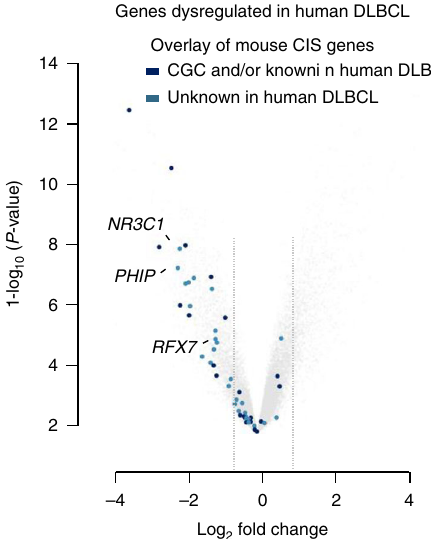
Fig. 5 CIS genes are signi fi cantly downregulated in human DLBCL. Volcano plot shows negatively (left) and positively (right) regulated genes in human DLBCL samples relative to non-malignant B cells (centroblasts) (GSE12453). Gray lines indicate log 2 fold changes of − 0.8 and 0.8. Dark blue colored points represent human orthologues of genes from the top 50 CIS list that are included in the Cancer Gene Census (CGC) database and/ or have already implicated roles in DLBCL. Light blue colored points